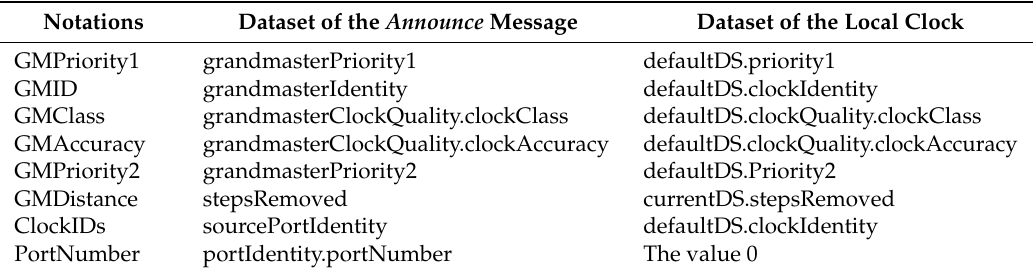
Table 1. Information sources for dataset comparison in the BMC